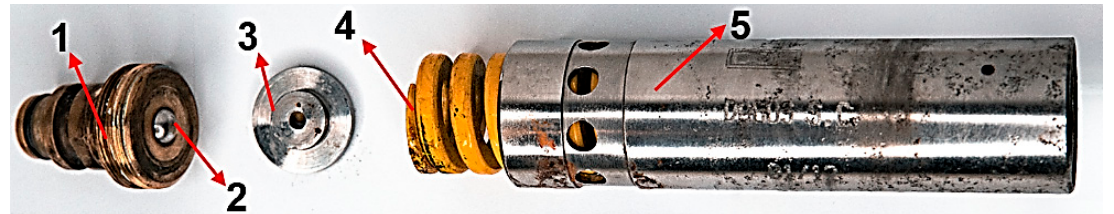
Figure 3. An example of the overflow valve: 1–O-ring of slide piston, 2–slide piston, 3–piston disc, 4–spring, 5–adjusting nut cover.